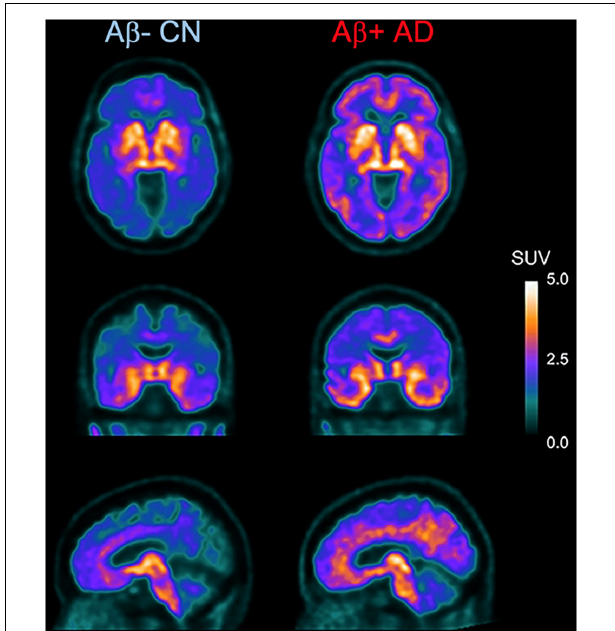
FIGURE 4 | Axial, coronal, and sagittal images showing higher and widespread binding of [ 18 F]SMBT-1 in an A β -positive Alzheimer’s disease patient (A β + AD, right) compared to an age-matched A β -negative cognitive unimpaired control (A β - CN, left). (Courtesy of Drs. Victor Villemagne and Christopher